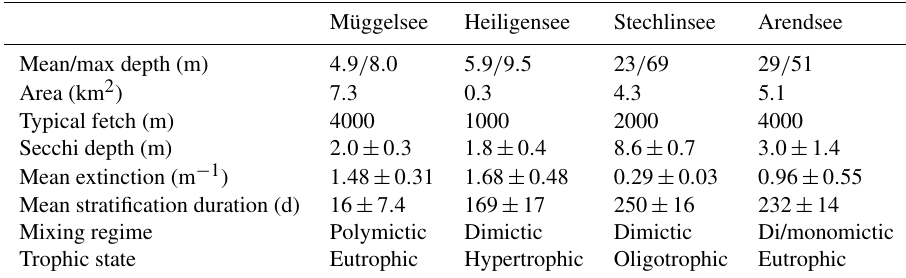
Table 1. Characteristics of the four study lakes.